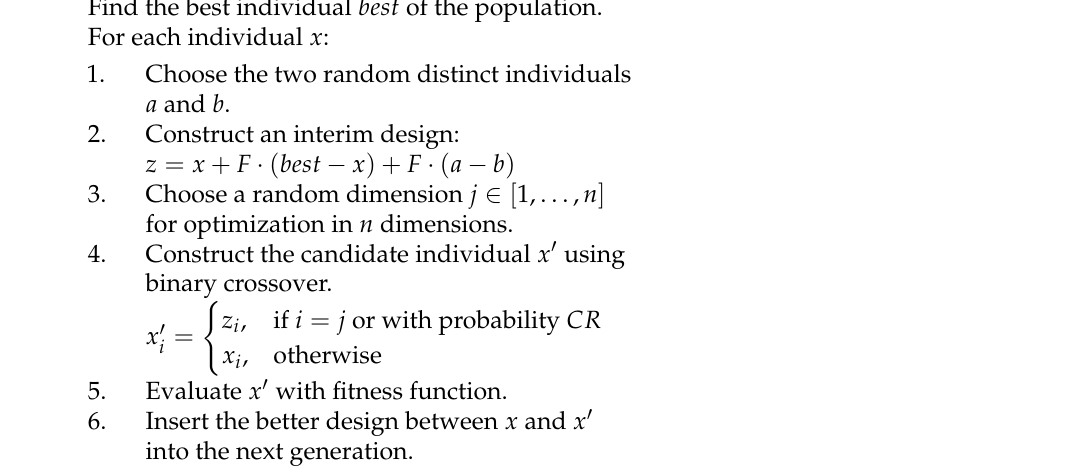
Algorithm 1 Procedure of the individual steps for one iteration of the differential evolution